Question: Give a one-sentence summary of this figure.
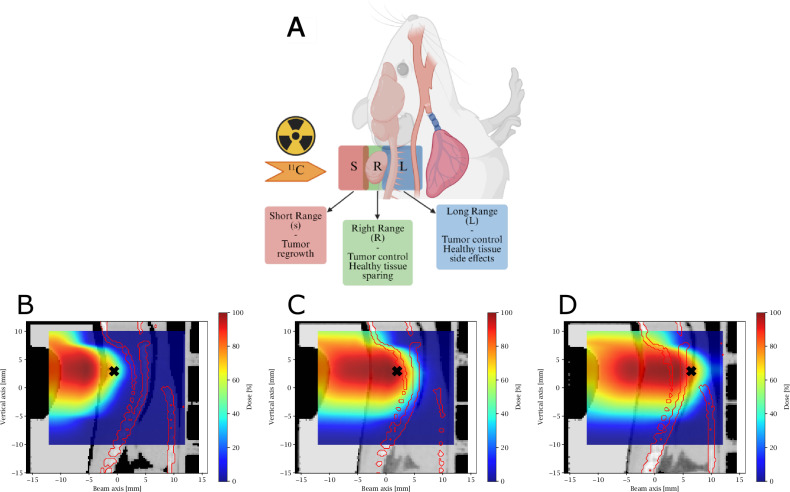
Answer: Goldilocks range. A Conceptual representation of the study and experimental groups. The 11 C-beam is used for three different treatment settings: Short range (S, red area), Right range (R, green area), and Long range (L, blue area). The working hypothesis is that the S range treatment will not cover the tumor, hence not controlling it, while in the L range the tumor will be treated, but there will be healthy tissue side effects caused by radiation. In the R range instead, the Goldilocks range, the tumor is eradicated and the healthy tissue spared. Created with BioRender.com . B FLUKA simulations showing the planned 11 C-ion dose (in percentage of the maximum dose value) distribution in the SARRP scan of a mouse in the sagittal view for the Short (S) experiment. Range at 60% of the maximum value (R60) is indicated with a black cross. C Same as in B for the Goldilocks (R) experiment, overlayed on the CBCT scan of a different mouse. The cross marks the range at 95% of the maximum value (R95). D Same as in B and C but now for the L mode experiment, overlayed on the CBCT scan of a mouse part of the L group. The cross marks the range at 80% of the maximum value (R80). Figures ( B – D ) were reoriented to be consistent with the reference frame of the PET scanner.